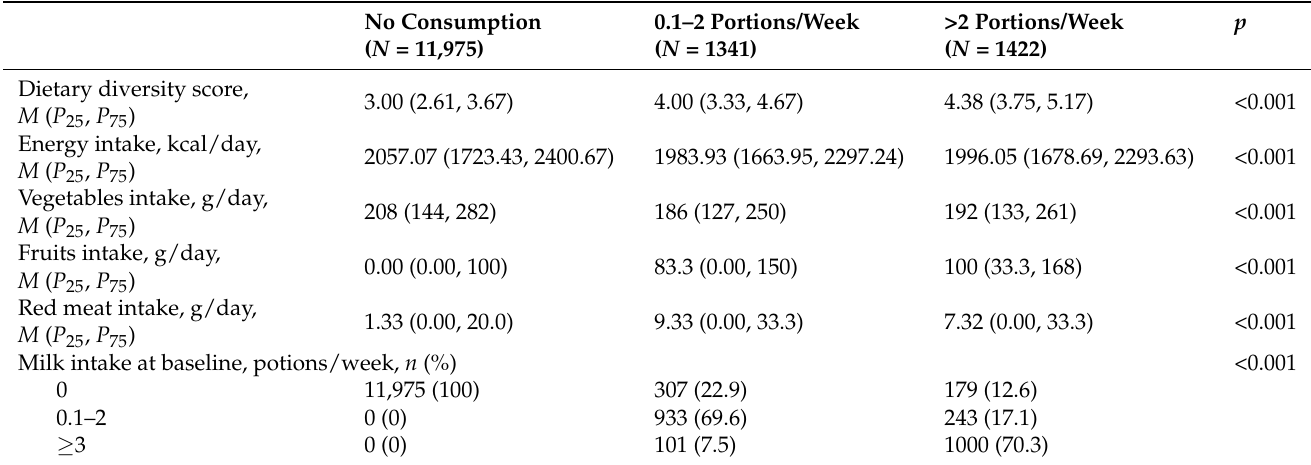
Table 2. Dietary intake characteristics of participants.